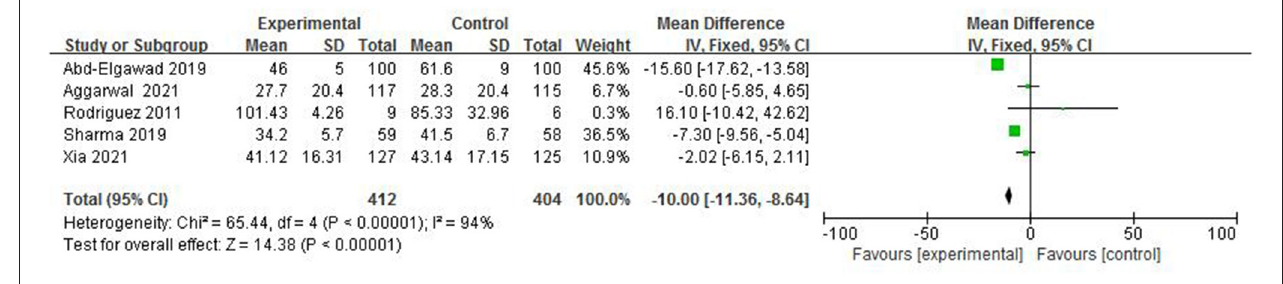
FIGURE 8 | Forest plot of duration of hospital.